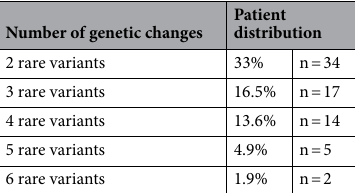
Table S3. Among them, majority (n = 7, 58.3%) had VUS in IRF2BP2 gene, and 25% (n = 3) had variations in either CARD1, CR2, CD19, or NFKB2 genes. In addition, TRNT1 and NFKB1 genes were mutated in 2 (16.7%) patients while VUSs in PLCG2, CD81, TNFRSF13B and TTC37 genes were detected in only one (8.3%) patient. Thirteen (12.6%) patients had no rare variants detected. Eighteen (17.5%) patients had only one rare variant